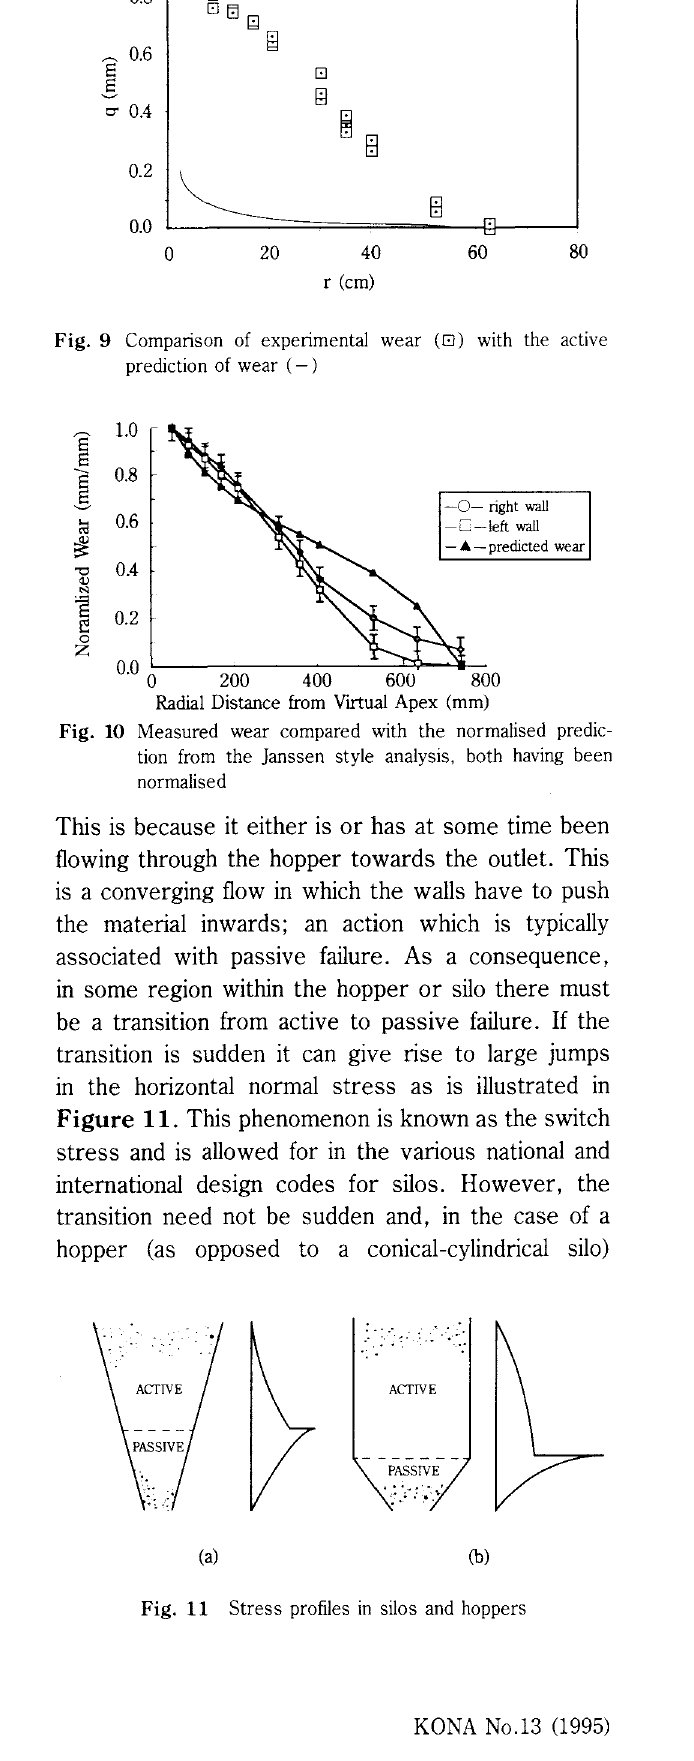
Fig. 11 Stress profiles in silos and hoppers